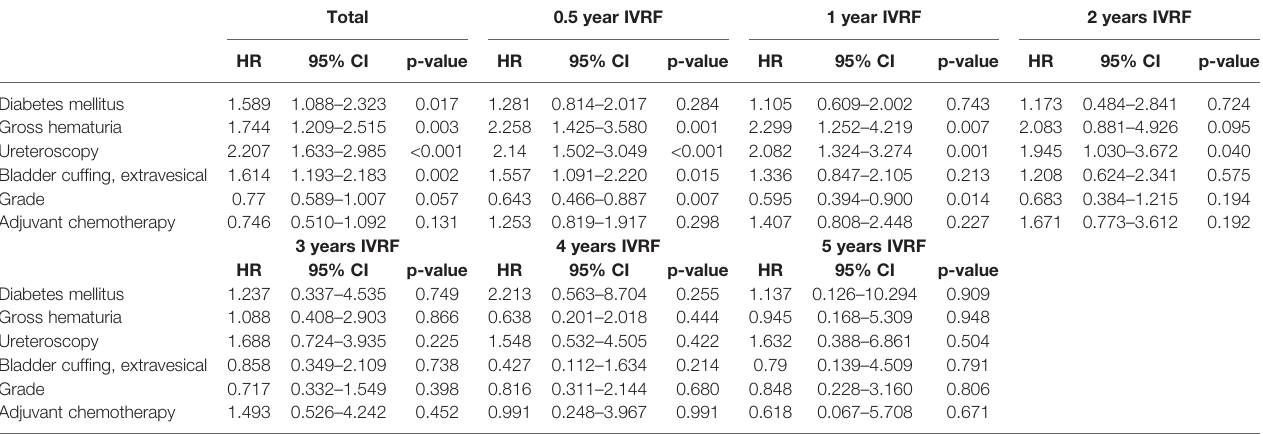
TABLE 4 | Risk factors for IVR in patients with UTUC who had no history of bladder